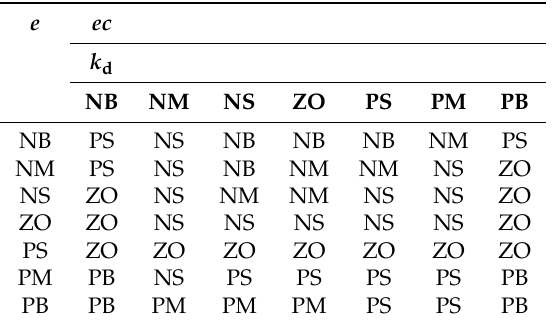
Table 5. Fuzzy rule k d .